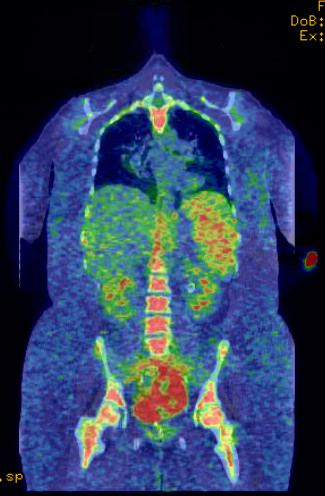
Positron emission tomography scan showing metabolic activity only in the bladder, prior to cystectomy. There is no evidence of regional or distant metastasis. There is slight increased activity in the skeletal system which is probably secondary to a marrow stenting agent.